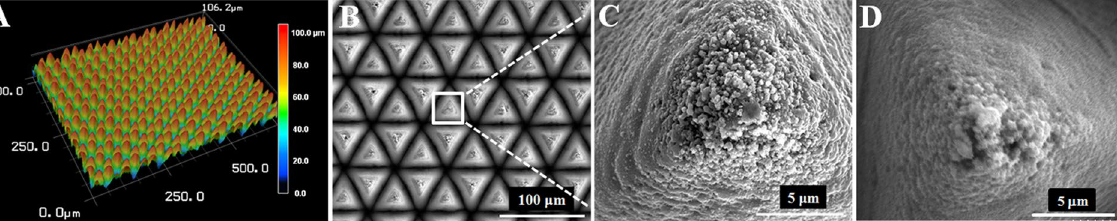
Figure 4. ( A ) LSCM image, ( B ) and ( C ) FESEM top-view images at different magnifications of fs-Ti, and ( D ) SEM top-view image of H